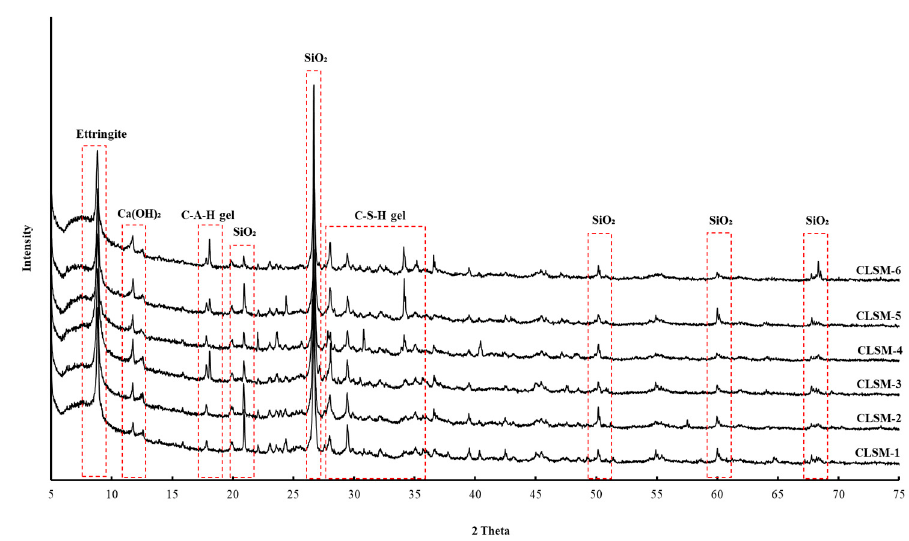
Figure 8. 7-d XRD results for different W/B values.